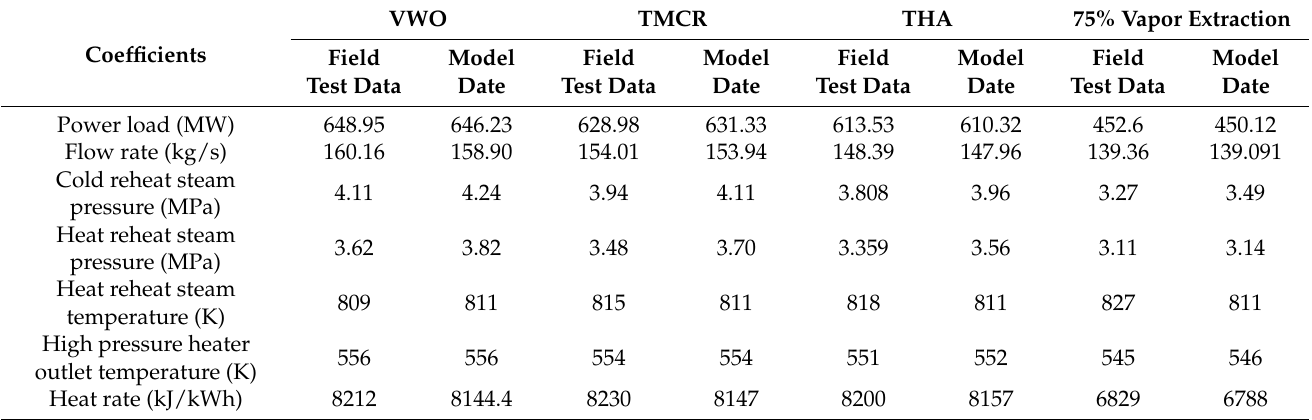
Table 2. Comparison of main thermal parameters for steady-state working